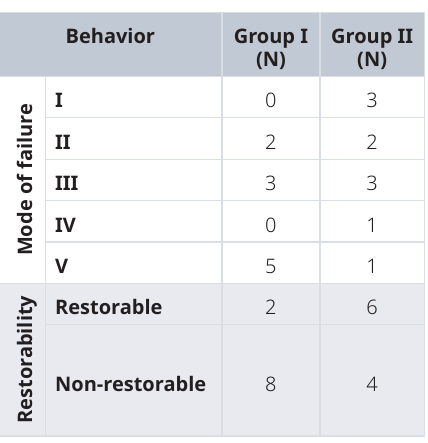
Table 6. Number of samples of Groups I and II relative to mode of failure, with restorability reported.